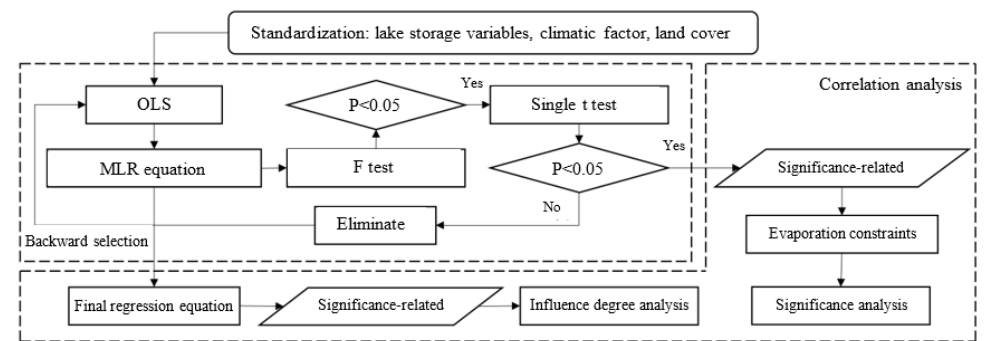
Figure 2. Flow chart of correlation analysis.